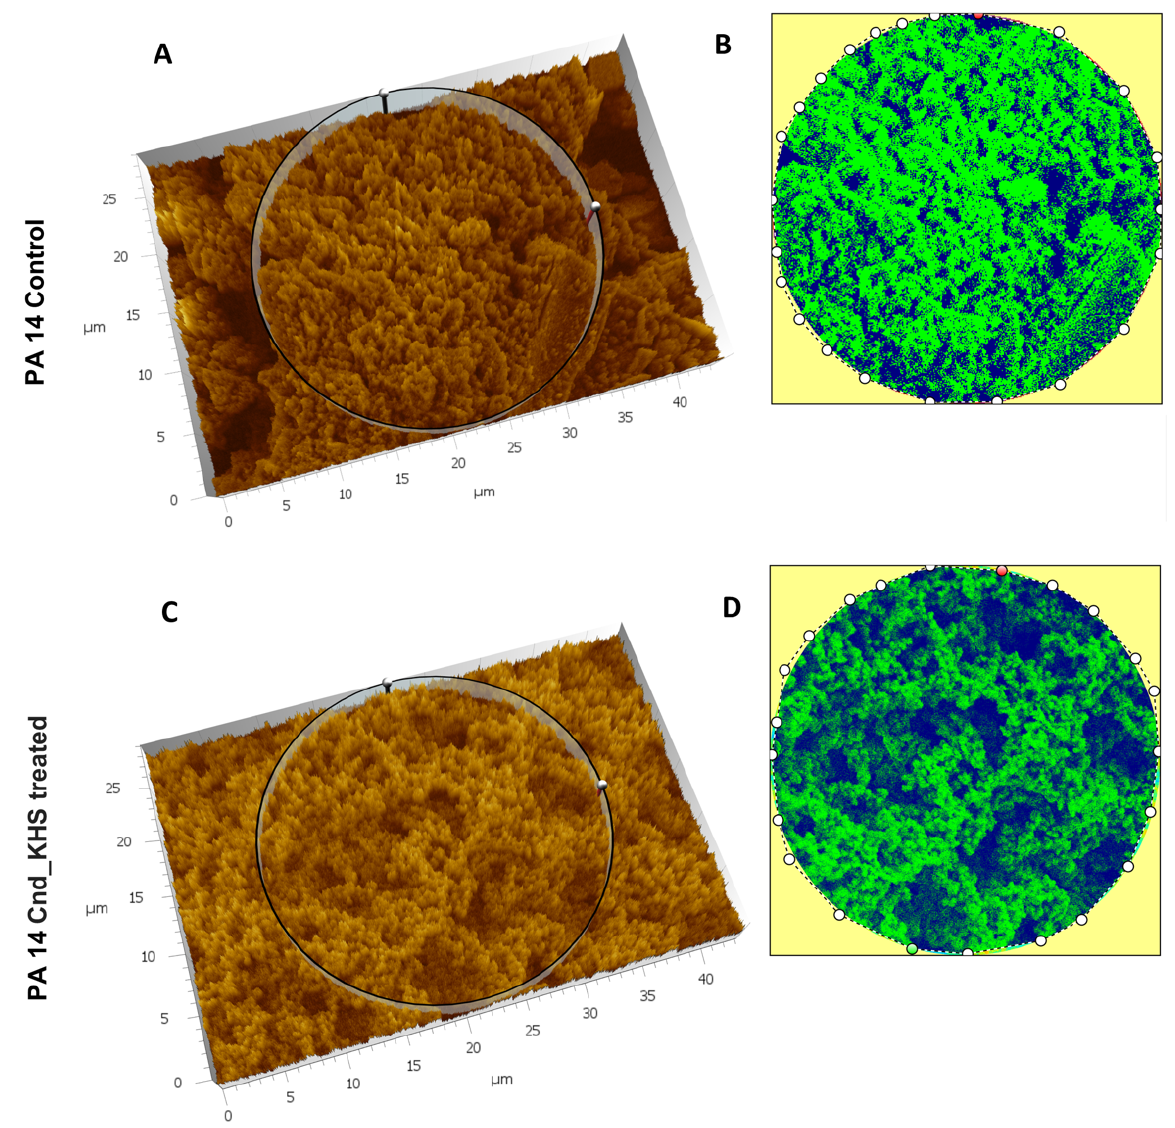
Figure 3. Three-dimensional reconstruction and analysis of P. aeruginosa PA14 ( A , B ) and P. aeruginosa PA14 treated with KHS-Cnd ( C , D ). The magnification is 3.00 K. ( A ) The spongy surface of untreated P. aeruginosa PA14 biofilm is imagined in 3D. ( B ) The circle represents the extracted area shown in false colors and related to untreated PA14. ( C ) The spongy surface of KHS-Cnd treated P. aeruginosa PA14 biofilm is imagined in 3D. ( D ) The circle represents the extracted area shown in false colors and related to KHS-Cnd treated P. aeruginosa PA14. High elevated areas corresponding to ECM trabeculae are colored in green. The labyrinthic channel system is represented in blue. Treatment with KHS-Cnd showed a less robust effect on the P. aeruginosa 27P ultra- structure. The image at low magnification (C) of the treated biofilm showed a spongy appearance on all of the sample surface, namely, less compact when compared to the control sample (Figure 4A). At higher magnification of the treated biofilm (D), the edges of the laminae formed an ECM 3D network, which appeared curly as in the control sample (comparing Figure 4B of the control sample with Figure 4D of the treated sample), and the porosity did not significantly